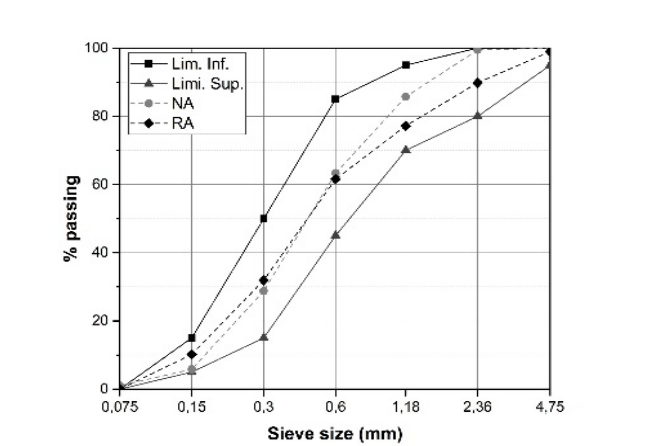
Figure 1. Size distribution of natural and recycled fine aggregate. NA = Natural Aggregate. RA = Recycled Aggregate.